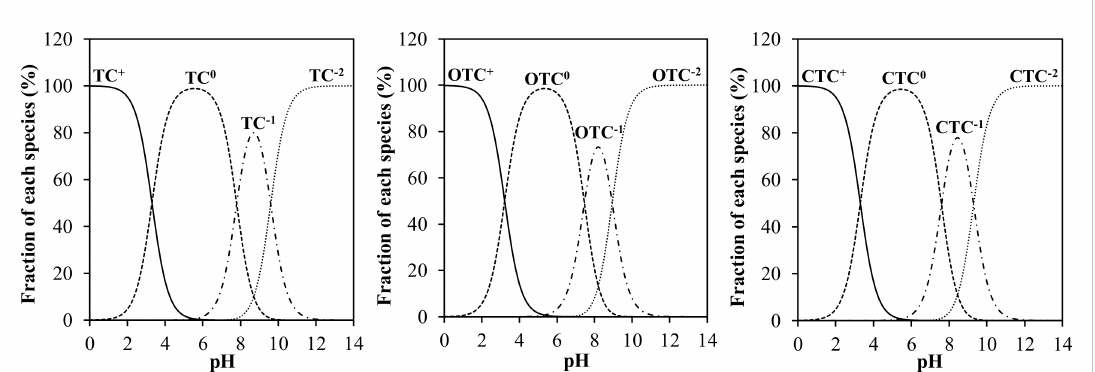
Figure 1. Percentage of each species of tetracycline (TC), oxytetracycline (OTC), and chlortetracycline (CTC) as a function of pH.